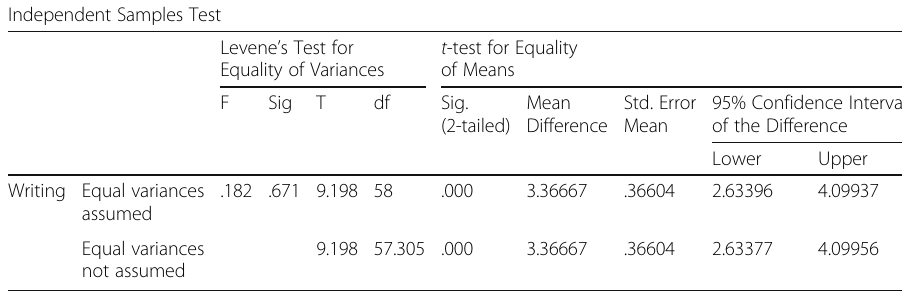
Table 12 Independent Samples Test Independent Samples Test